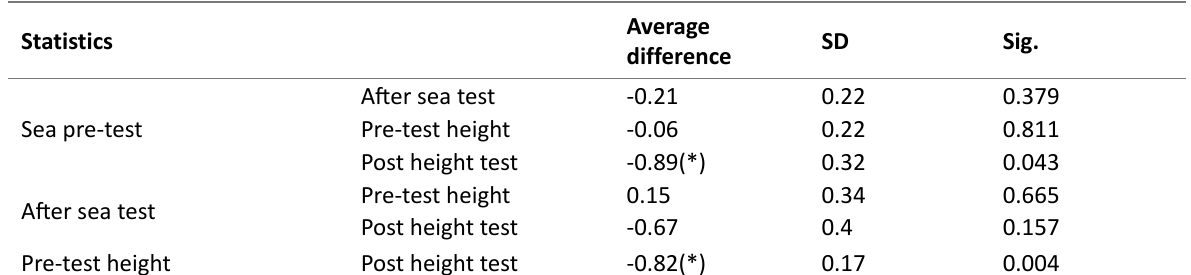
Table 2. Test repeated tests of testosterone at various stages